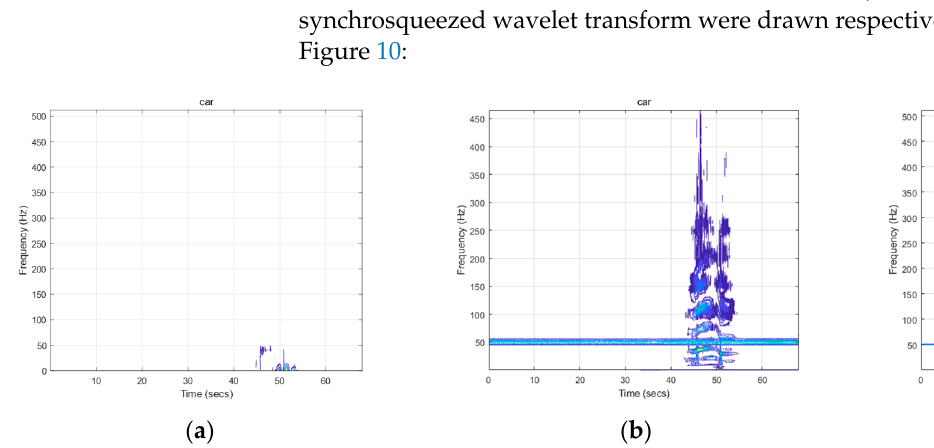
Figure 9. (40–60 s, 30–70 Hz) resolution STFT, CWT, and SSWT images. ( a – c ) Time-frequency diagrams of STFT, CWT, and WSST are enlarged to clearly show the changes in the time-frequency diagram.